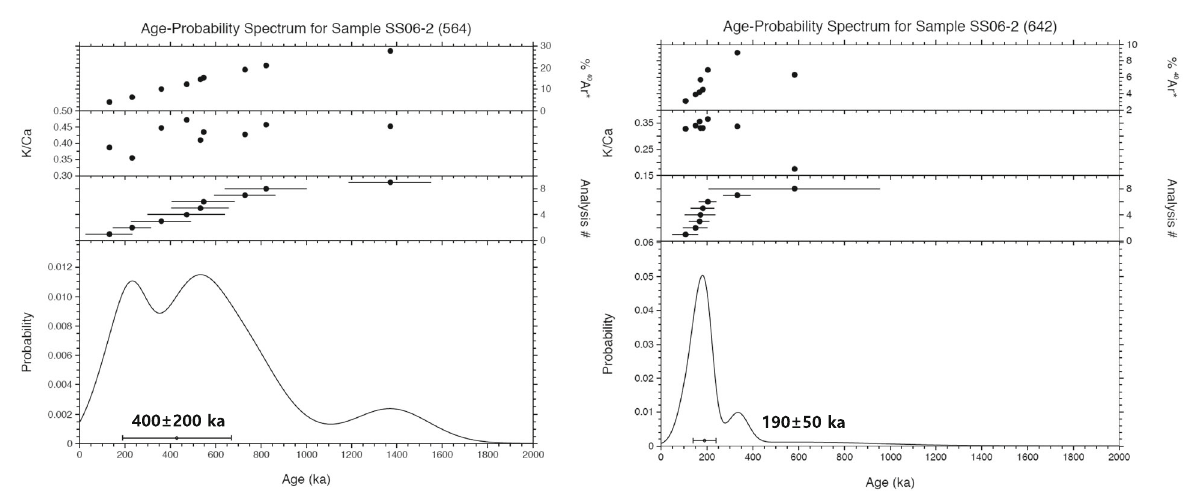
Fig. 4 Age probability diagrams of the basaltic rock. Left and right diagrams represent the 40 Ar/ 39 Ar ages of multiple aliquots using the original and modified gas preparation protocol, respectively. Note that the the precision of multiple aliquot analysis is significantly improved by using the